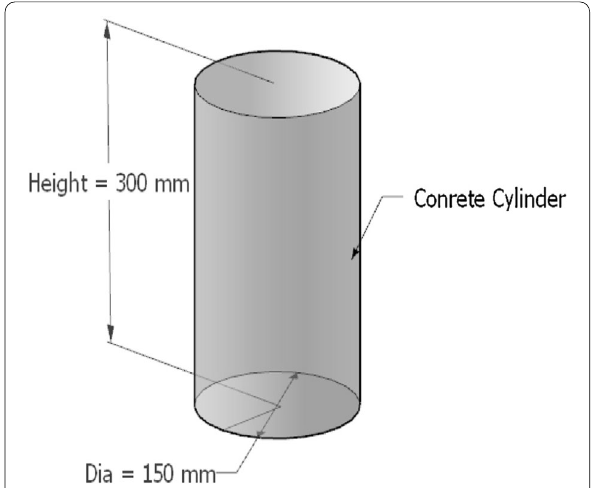
Fig. 1 Details of concrete